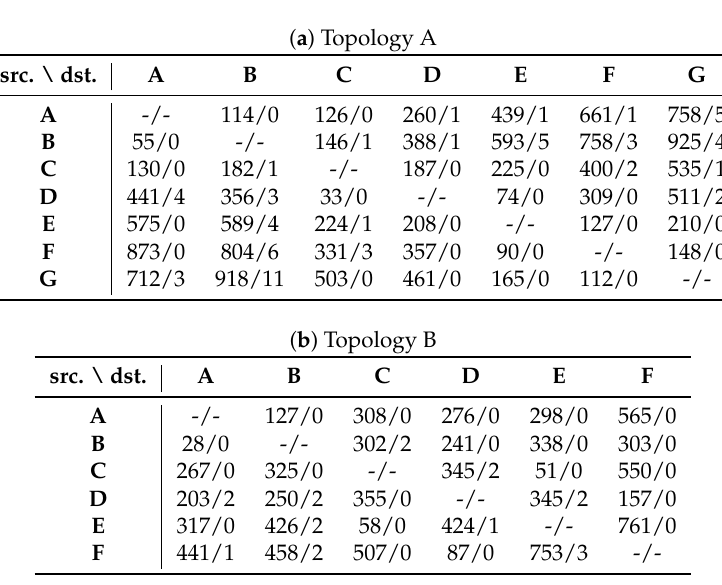
Table 2. RTT (ms)/# of failures.